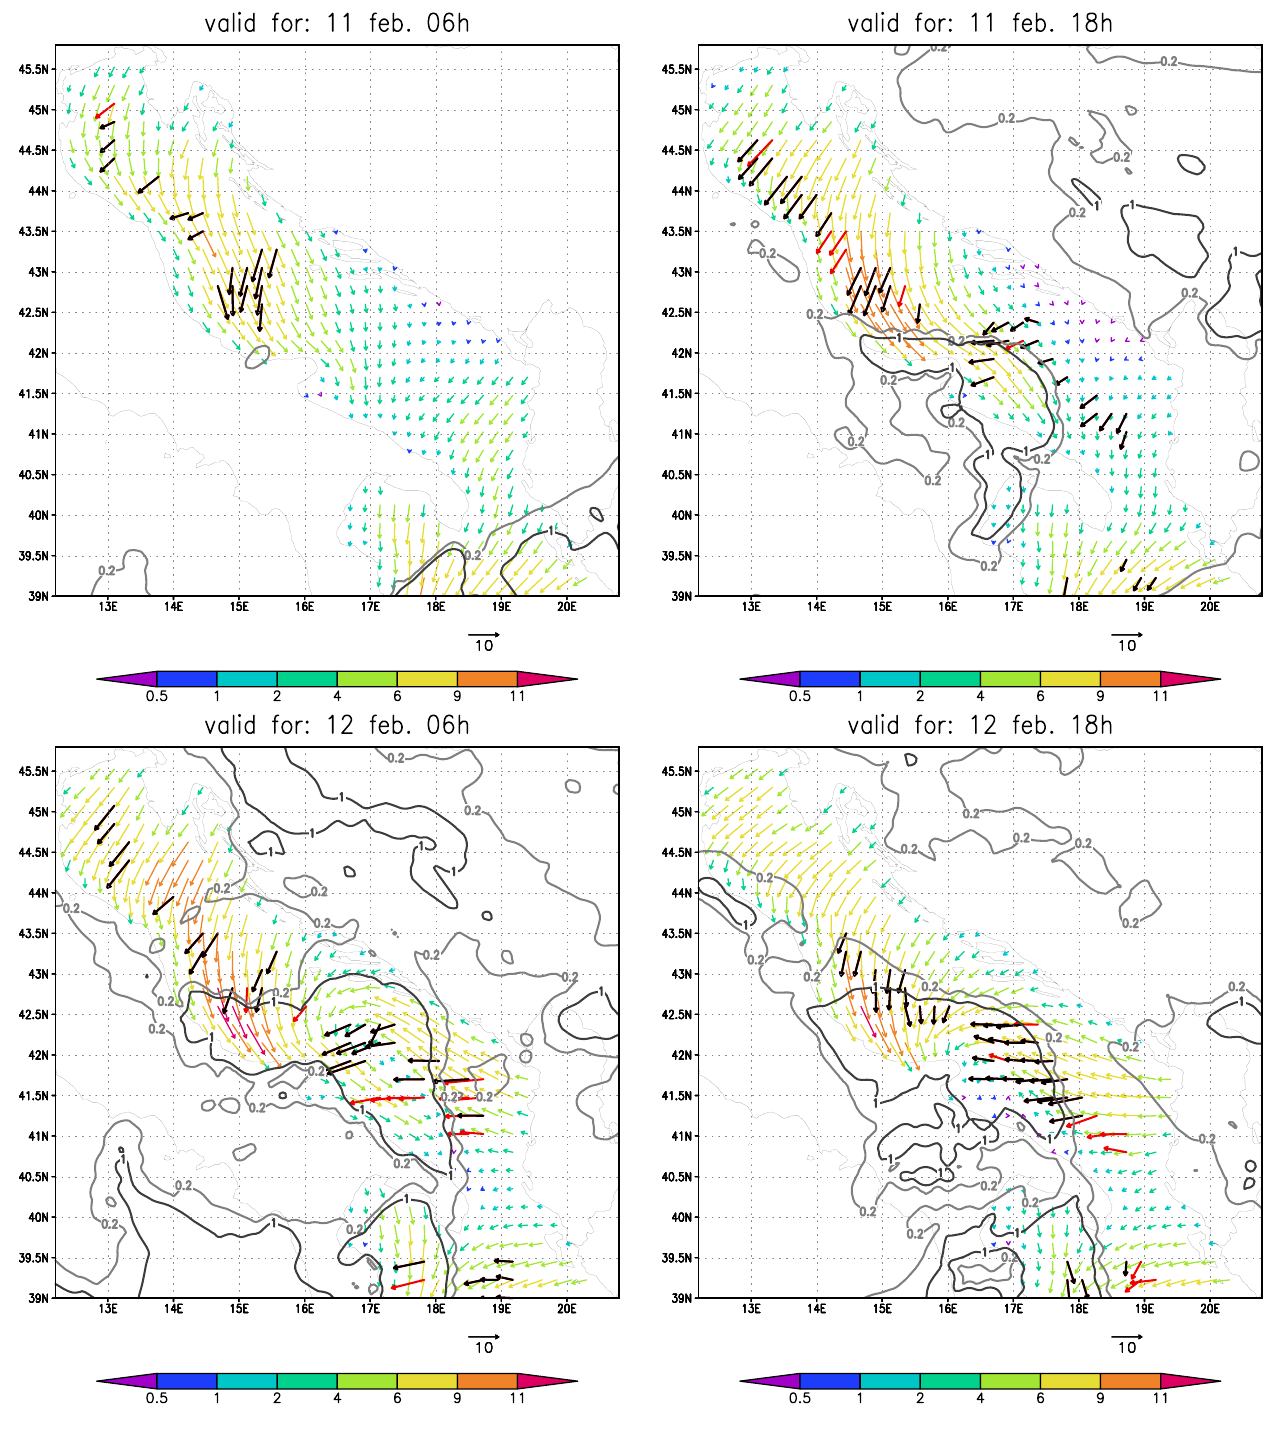
Fig. 11. Verification of the surface winds from satellite data. Forecasts are for 11–12 February for two satellite passes, at 06:00h and 18:00h. Heavy black arrows are observations, with flagged data indicated by red arrows. Forecast winds are shown in lighter colours. Gray indicates isolines of precipitation predicted by the model; these may indicate areas with rain or